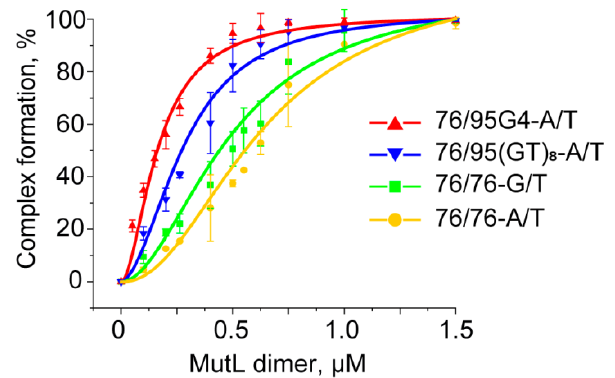
Figure 8. Binding of ecMutL to DNA ligands. The yield of nucleic acid–protein complexes, as calculated from the data of the EMSA, is plotted against ecMutL concentration (0–3.0 µ M) at 100 nM DNA ( p < 0.05).